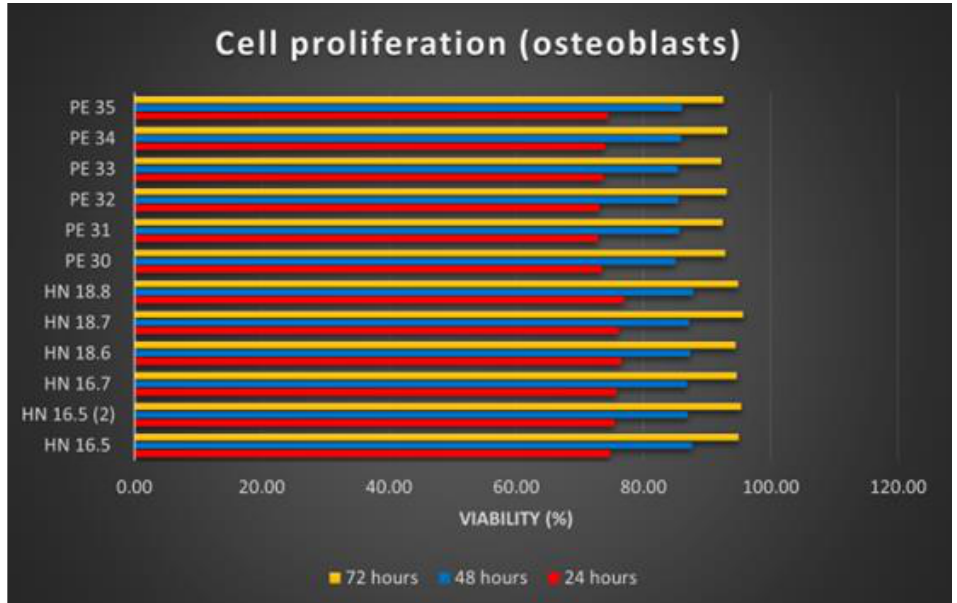
Figure 8. Cell proliferation of osteoblasts on HAp samples.